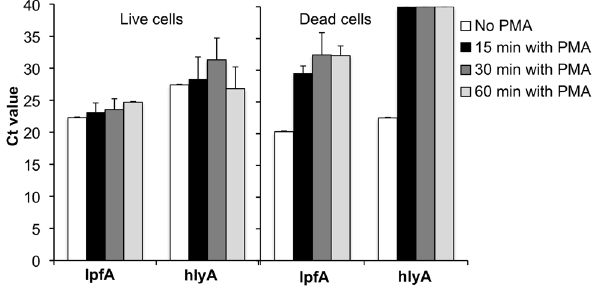
Figure 1. Effect of incubation time and PCR primer on detection of live and dead cells by real-time PCR. Live or isopropanol-inactivated dead cells of E. coli O157:H7 ATCC 700728 (5 6 10 7 CFU) were incubated in the dark with or without 40 m M PMA for 15, 30, or 60. Real-time PCR was performed using the lpfA or hlyA primer sets [20,21]. Each bar represents the mean 6 stdev for three independent replicates.